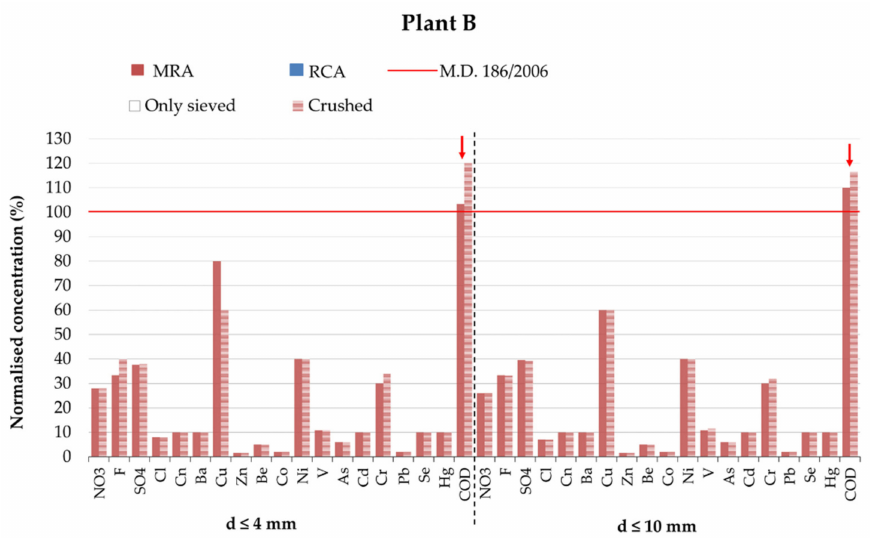
Figure 11. Plant B: trend of pollutant concentrations in relation to the type of RA (RCA or MRA), particle sizes, and test conditions (i.e., material only sieved or